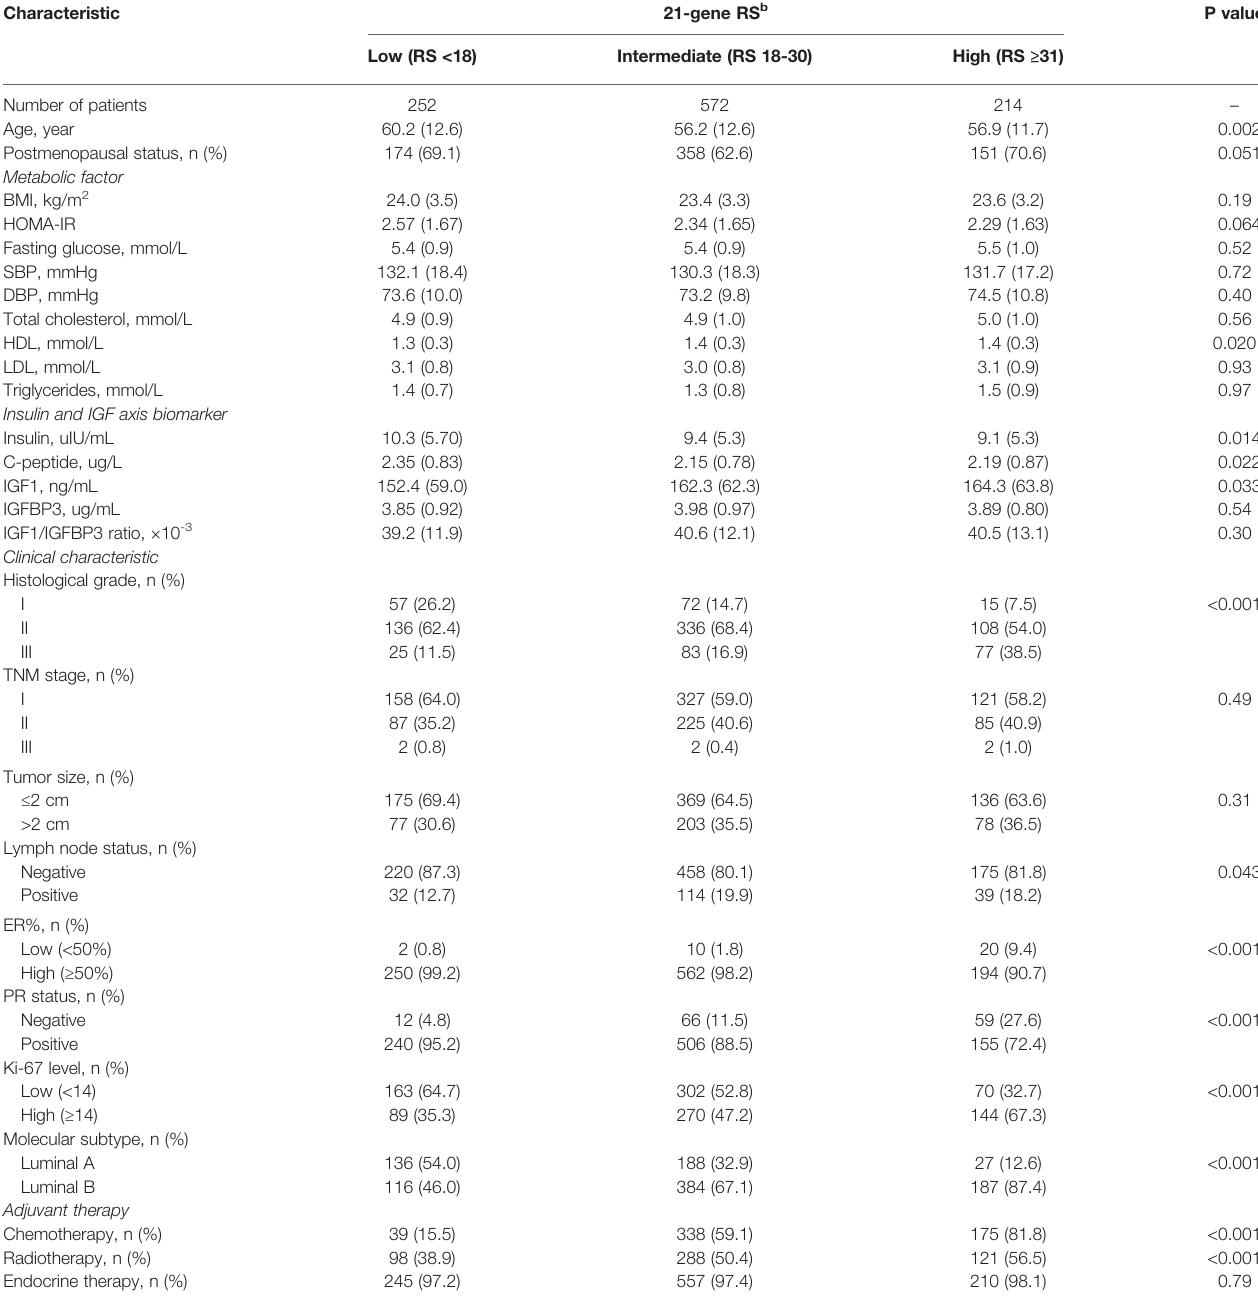
TABLE 1 | Baseline characteristics of breast cancer patients by the 21-gene RS categories a .